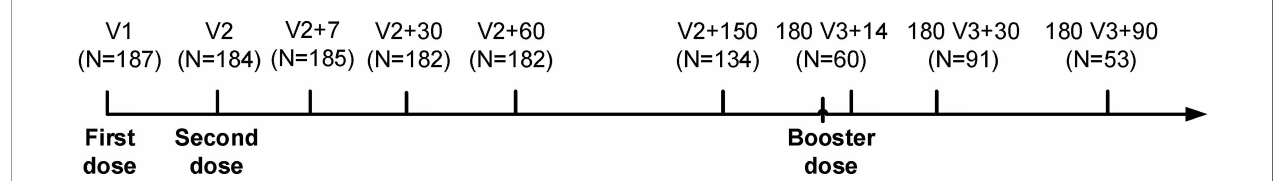
FIGURE 1 | Group entry process and time interval. V1: fi rst injection (before immunization). V2: second injection. V2+7: seven days after the second injection. V2 +30: one month after the second injection. V2+60: two months after the second injection. V2+150: fi ve months after the second injection. 180 V3+14: 14 days after booster injection. 180 V3+30: one month after booster injection. 180 V3+90: three months after